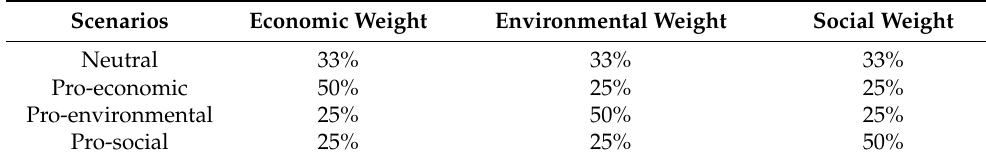
Table 8. The scenario weights.